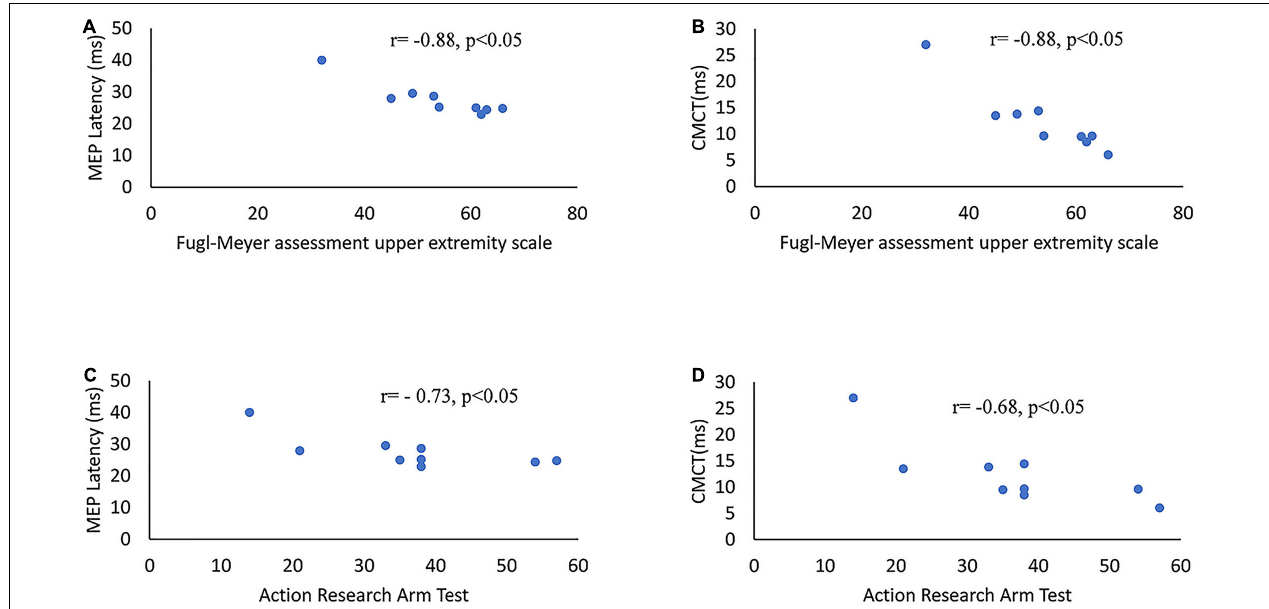
FIGURE 4 | Scatter diagrams of clinical scales and MEP parameters on the affected side of stroke survivors. (A) MEP latency versus Fugl-Meyer assessment upper extremity scales. (B) CMCT of MEP versus Fugl-Meyer assessment upper extremity scales. (C) MEP latency versus ARAT. (D) CMCT of MEP versus ARAT. ARAT, Action Research Arm Test; CMCT, central motor conduction time.